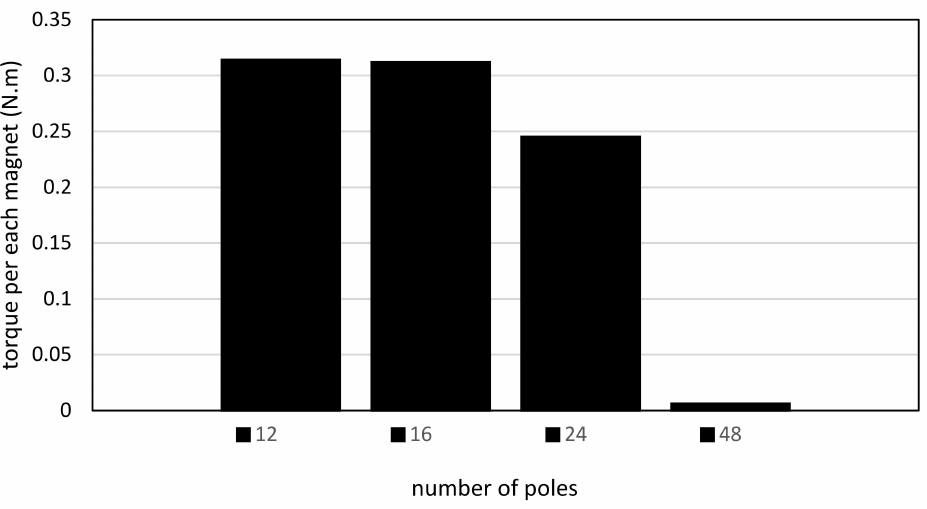
Figure 13. Torque per number of magnets vs. pole number at rotational speed of 100